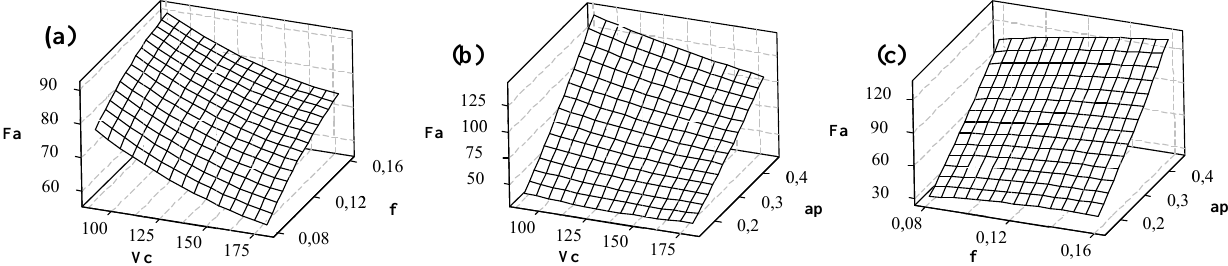
Fig.3. (a) 3D surface plots for interaction effects of feed rate and cutting speed, (b) depth of cut and cutting speed, and (c) depth of cut and feed rate on feed force